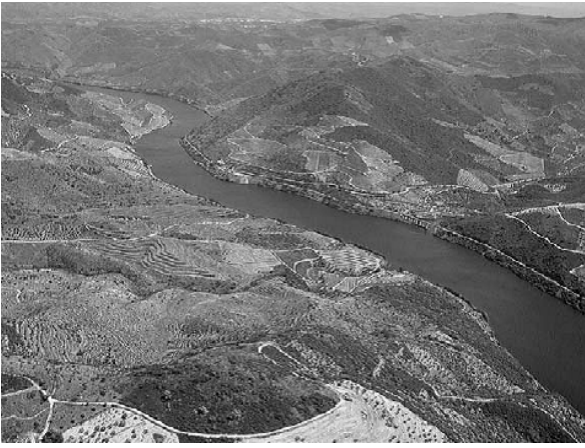
Figure 1: Alto Douro Wine